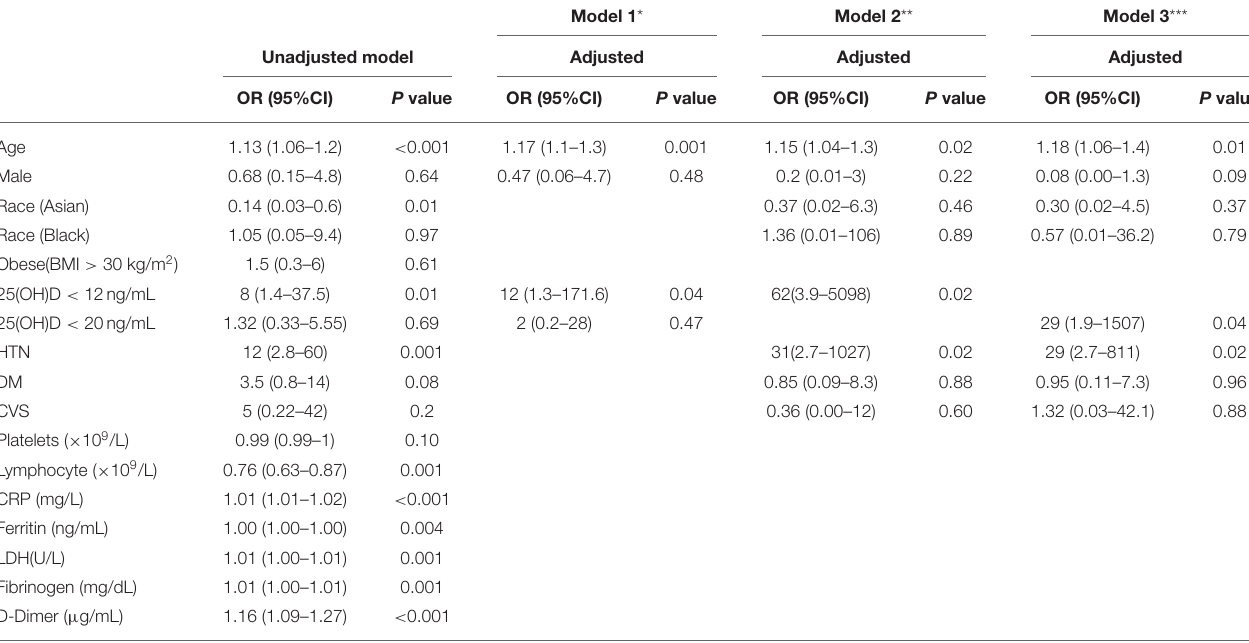
TABLE 4 | Significant predictors of mortality univariate and multivariate logistic regression models.